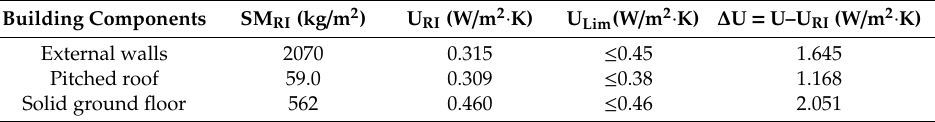
Table 5. Thermal transmittance and surface density of the opaque components.